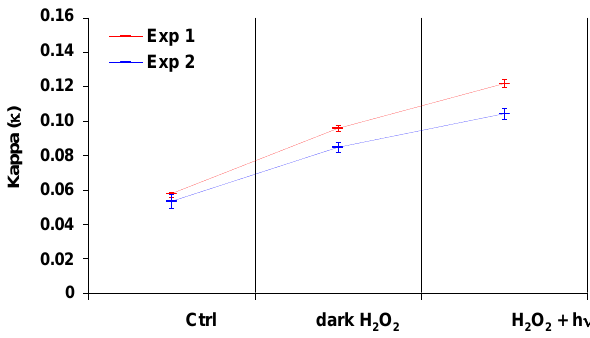
20 Figure 3 : Hygroscopicity parameter kappa (  ) measured during nebulization of “control” 21 Fig. 3. Hygroscopicity parameter kappa ( κ ) measured during neb- samples (Ctrl), “dark H 2 O 2 ” samples (dark H 2 O 2 ) and “H 2 O 2 + h  ” samples (H 2 O 2 + h  ) for 22 the two isoprene experiments. The κ values were measured from hygroscopic growth factor 23 ulization of “control” samples (Ctrl), “dark H 2 O 2 ” samples (dark data (HGF, for 50 nm dry particle diameters). Error bars represent the standard deviations 24 H 2 O 2 ) and “H 2 O 2 + hν ” samples (H 2 O 2 + hν ) for the two isoprene during 90 min of nebulization. 25 experiments. The κ values were measured from hygroscopic growth factor data (HGF, for 50nm dry particle diameters). Error bars rep- resent the standard deviations during 90min of